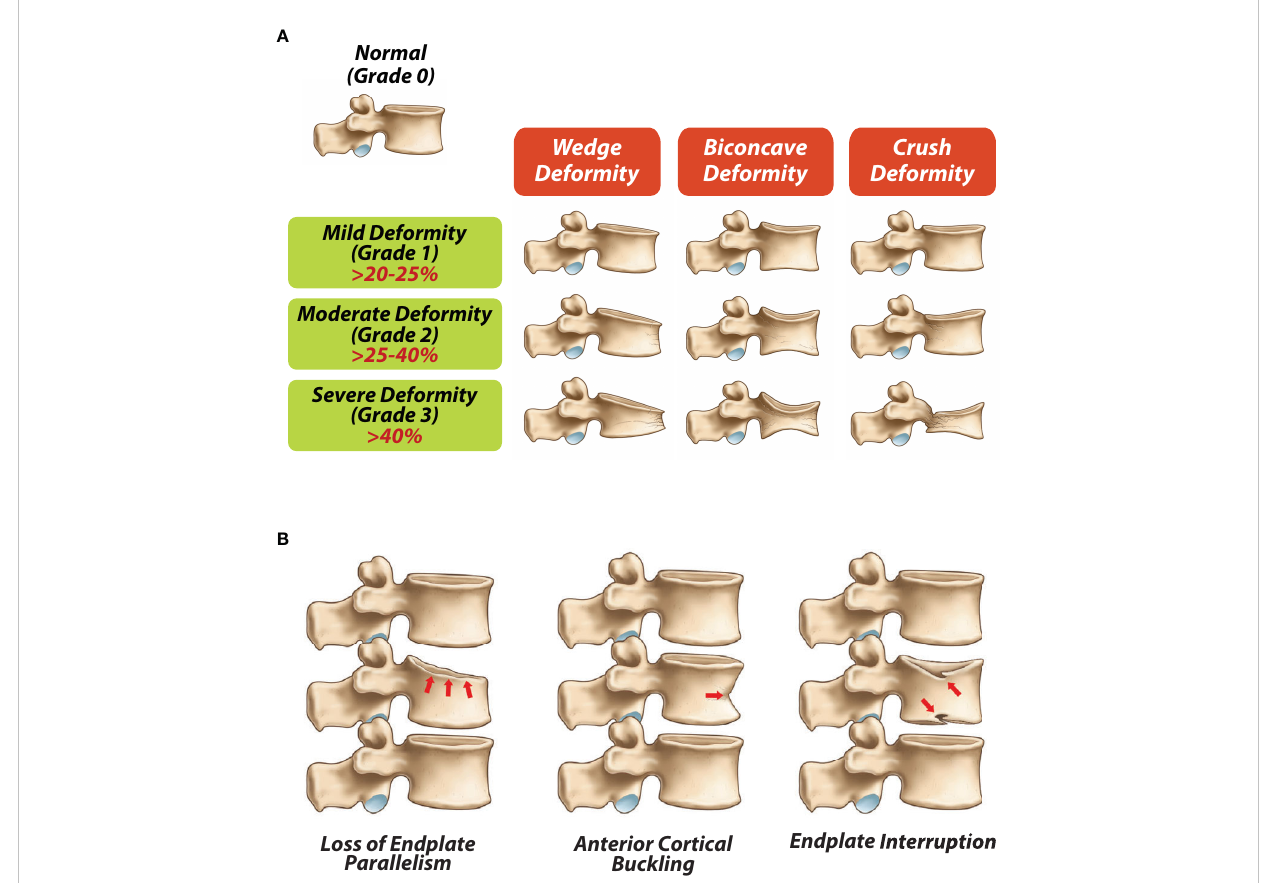
FIGURE 1 (A) Modi fi ed Genant semi-quantitave classi fi cation for vertebral frature assessments (adapted from Genant et al (31), (B) Qualitative radiological signs of vertebral fractures (adapted from Ward LM